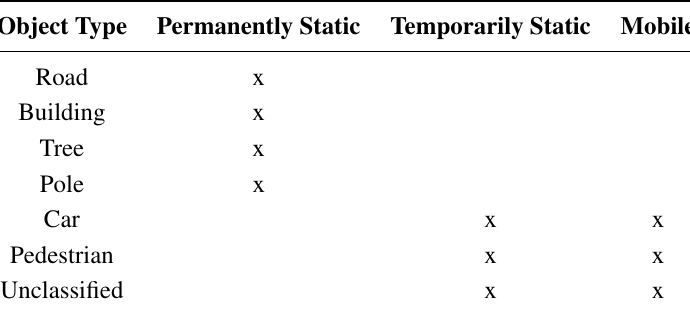
Table 1. Object classification chart.